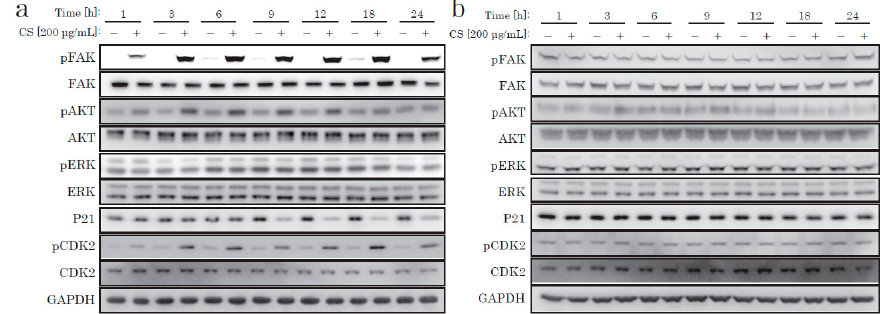
Figure 4. Western blotting of proteins regulating the intracellular signaling pathway. KFs ( a ) and NFs ( b ) were treated with CS for up to 24